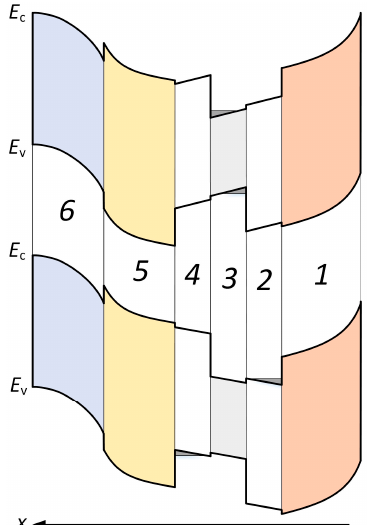
Figure 2. Energy band diagrams of the control heterostructure used in the photodetector with controlled relocation of carrier density peaks. The enumeration of regions is the same as in Figure 1: 1, n -Al a Ga 1 − a As region of upper Schottky control junction; 2, upper LT-In 1 − b Ga b As layer; 3, i -In 1 − c Ga c As d Sb 1 − d absorbing region; 4, lower LT-GaAs 1 − e Sb e layer; 5, n -Al a Ga 1 − a As region of lower control p - n junction; 6, p -GaAs region of lower control p - n junction. The upper diagram corresponds to the zero-voltage operation of the control heterostructure during the leading edge of a laser pulse. In the lower diagram, the bands are curved by the bias voltage, which is applied to control contacts during the back edge of an optical pulse.